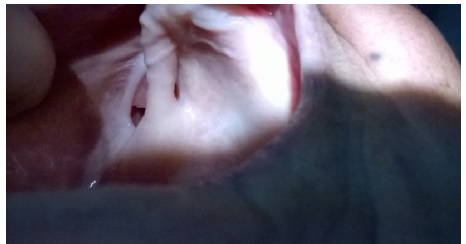
Figure 2. Left lateral view of oronasal fistula (ONF). Fistula can be seen extending from right buccal vestibule to right lateral part of hard palate with a reasonable amount of alveolar ridge overlying the